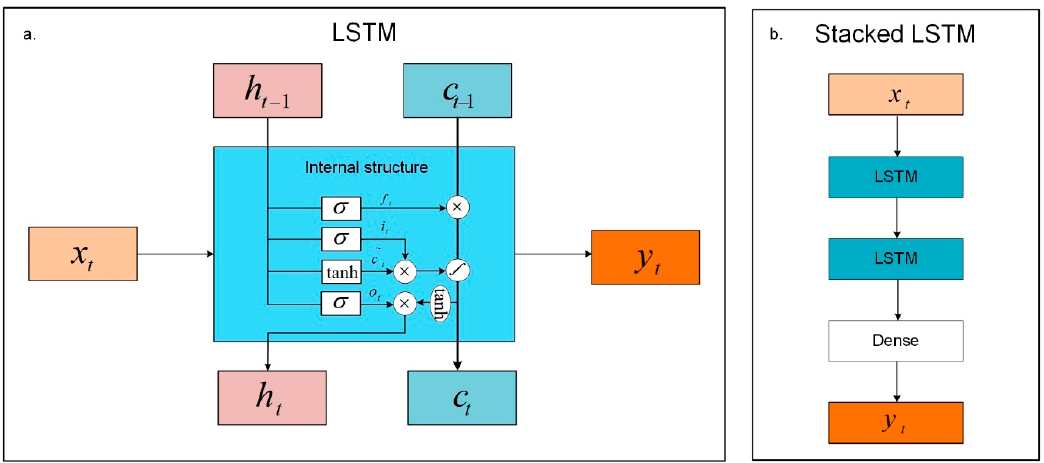
Figure 2. The structure of long short-term memory (LSTM) and stacked LSTM. ( a ). The structure of LSTM, including the internal structure; ( b ) the stacked LSTM structure with two LSTM layers.